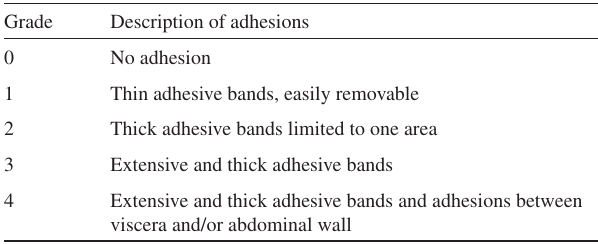
Table 1 - Blauer and Collins scale for macroscopic assess- ment of adhesion formation 9